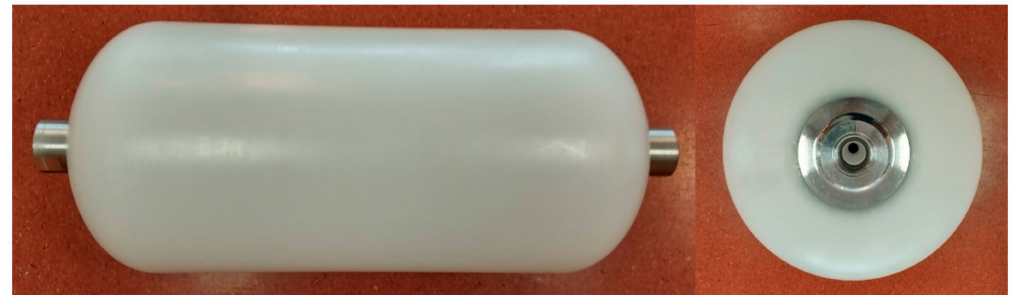
Figure 2. View of the exemplary HDPE liner for a hydrogen vessel, manufactured using rotomolding